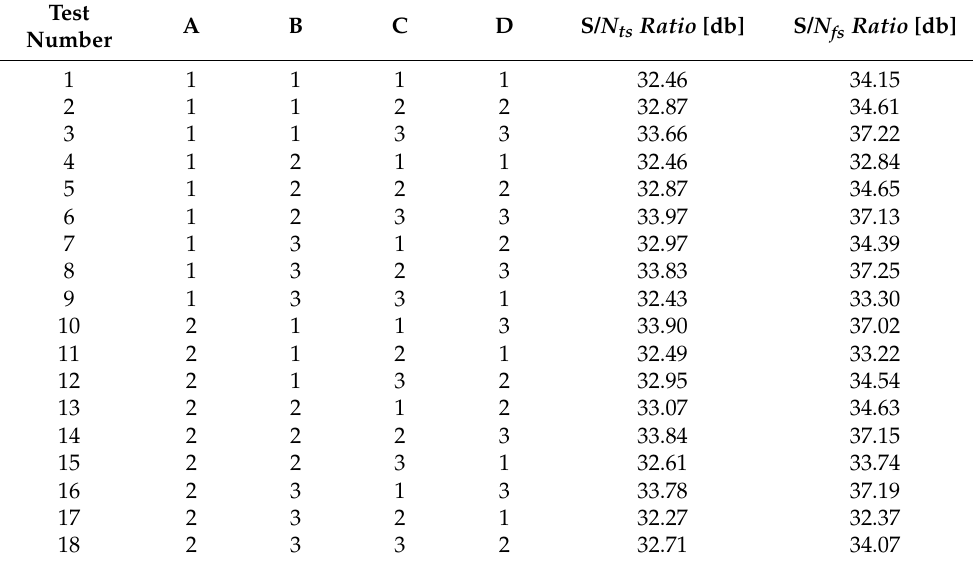
Table 5. S/N ratios for tensile and flexural strength.